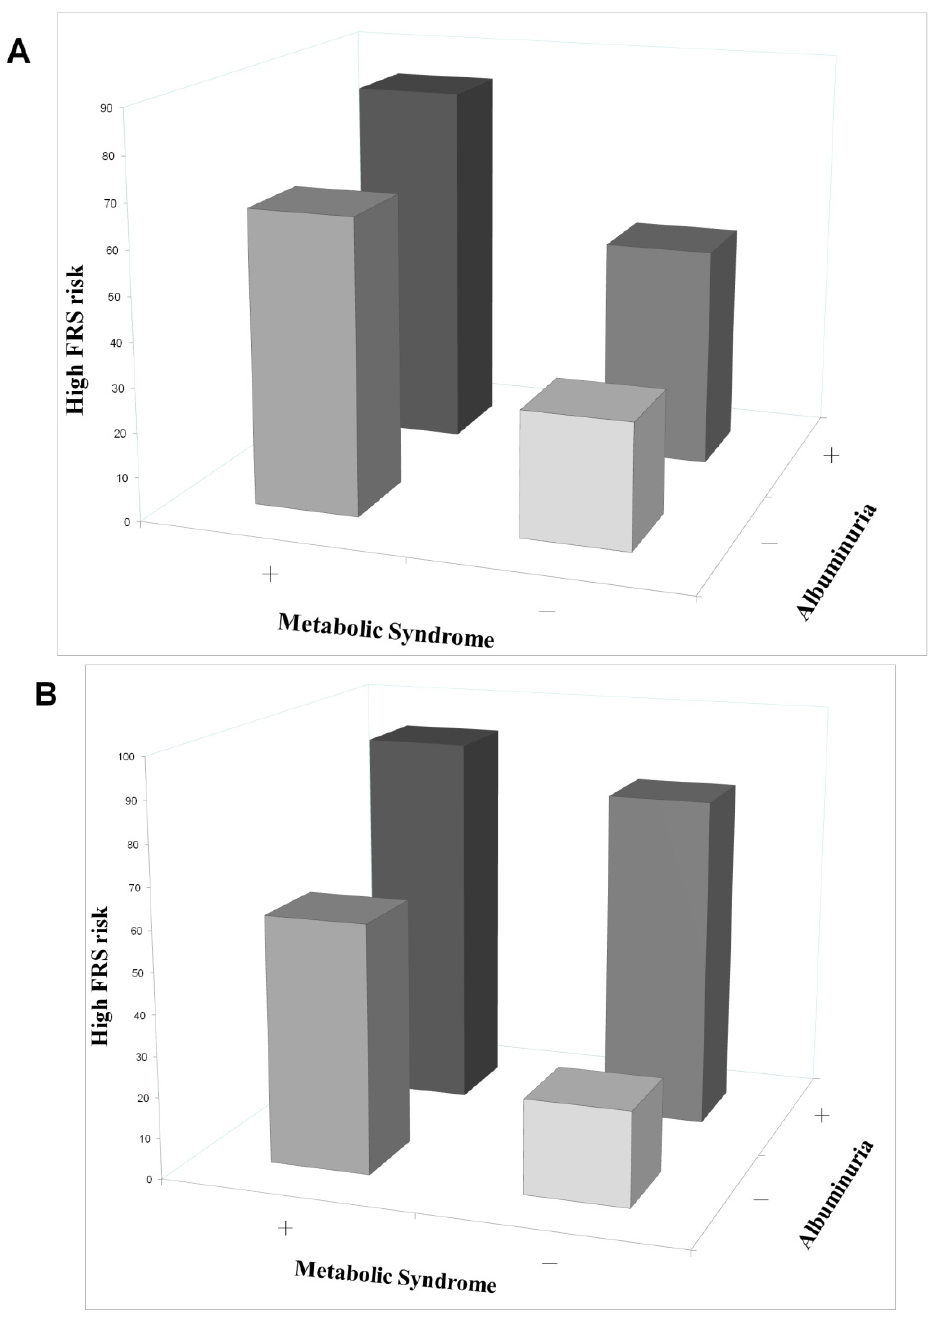
Figure 3. Occupational drivers ( A ) and community controls ( B ) with both metabolic syndrome and albuminuria showed the highest rate for high FRS risk ≥ 10% of 10-year